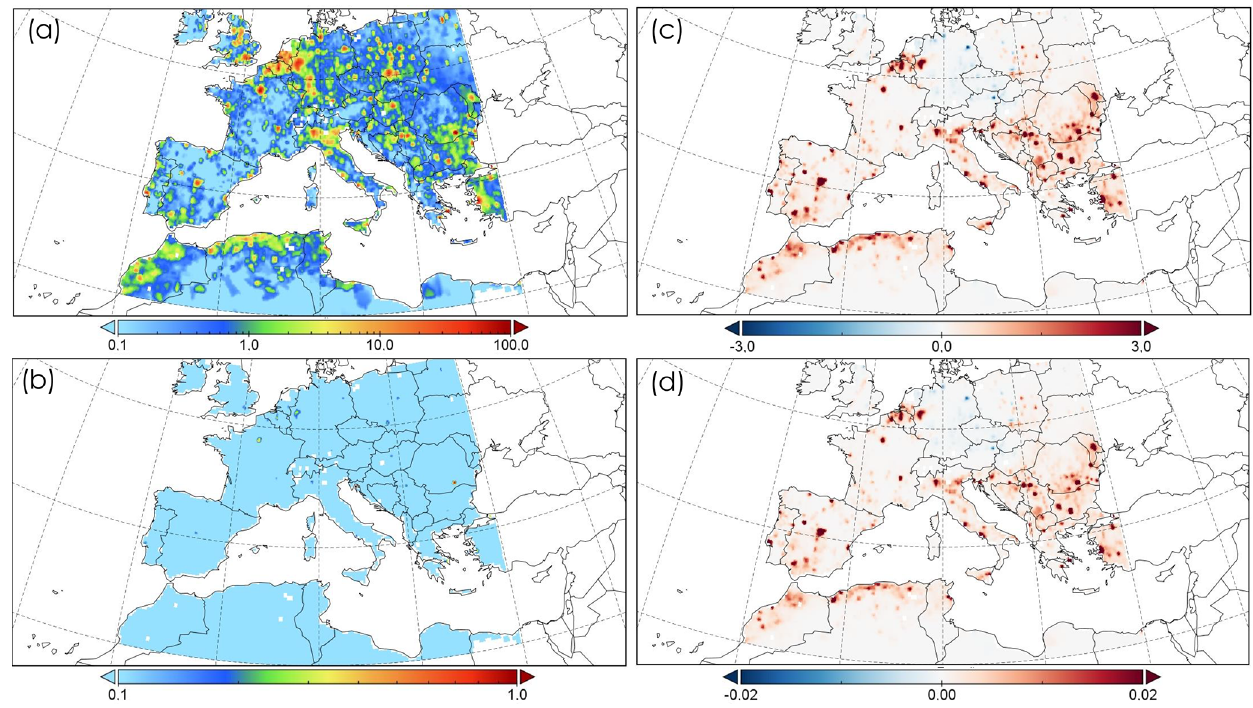
Figure 2. (a) Present cases of respiratory hospital admissions (RHA) and (b) associated costs, in millions of euros. (c) Changes projected in RHA cases and (d) changes in costs (millions of euros) under the RCP8.5 scenario